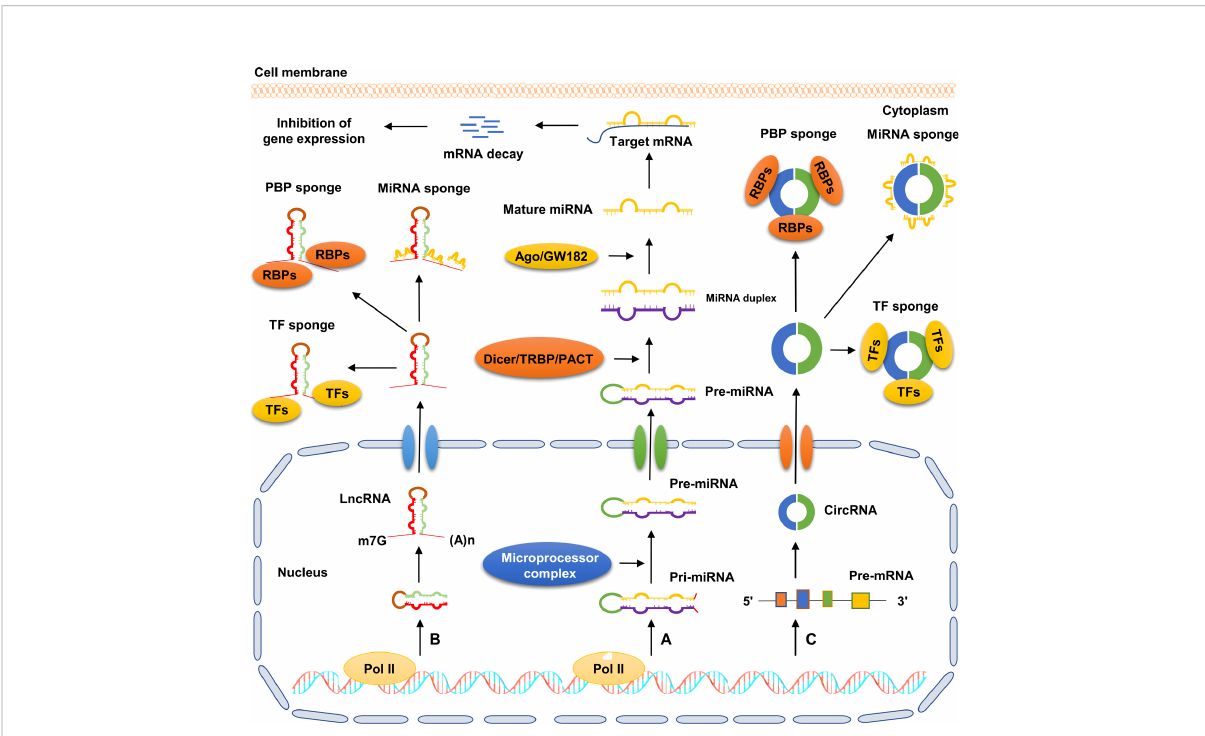
FIGURE 1 Schematic diagram of ncRNA biogenesis and action patterns. (A) Pri-miRNA is transcribed by RNA polymerasel II from genomic loci and further processed into pre-miRNA by microprocessor complex. Subsequently, pre-miRNA is exported to the cytoplasm and further processed into double-stranded miRNA via the Dicer/TRBP/PACT complex. Next, with the help of Ago/GW182, the double-stranded miRNA is processed into mature miRNA, which directly binds to the 3 ’ -UTR of target mRNA, and then facilitates its degradation. (B) LncRNA transcribed by RNA polymerase II is exported to the cytoplasm. Subsequently, lncRNA exerts its biological role by acting as sponges of miRNAs, RBPs, and TFs. (C) CircRNA is mainly derived from precursor mRNAs via back-splicing reaction, by which the single strand of circRNA forms a covalently closed- loop structure. CircRNA plays crucial roles in cellular processes by serving as sponges of miRNAs, RBPs, and